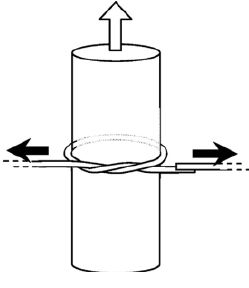
Figure 12. Schematic illustration of microfiber knot resonator tied on a copper rod. The upward arrow in the figure indicates the direction of the electric current in the copper rod